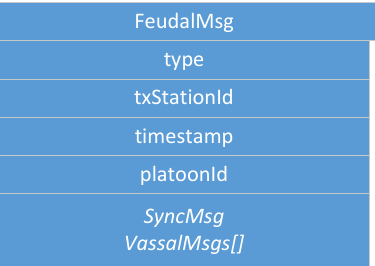
Figure 2. FeudalMsg : used for all ongoing communication during Feudalistic Platooning . The selection between SyncMsg and VassalMsg is context dependent and indicated by the type.